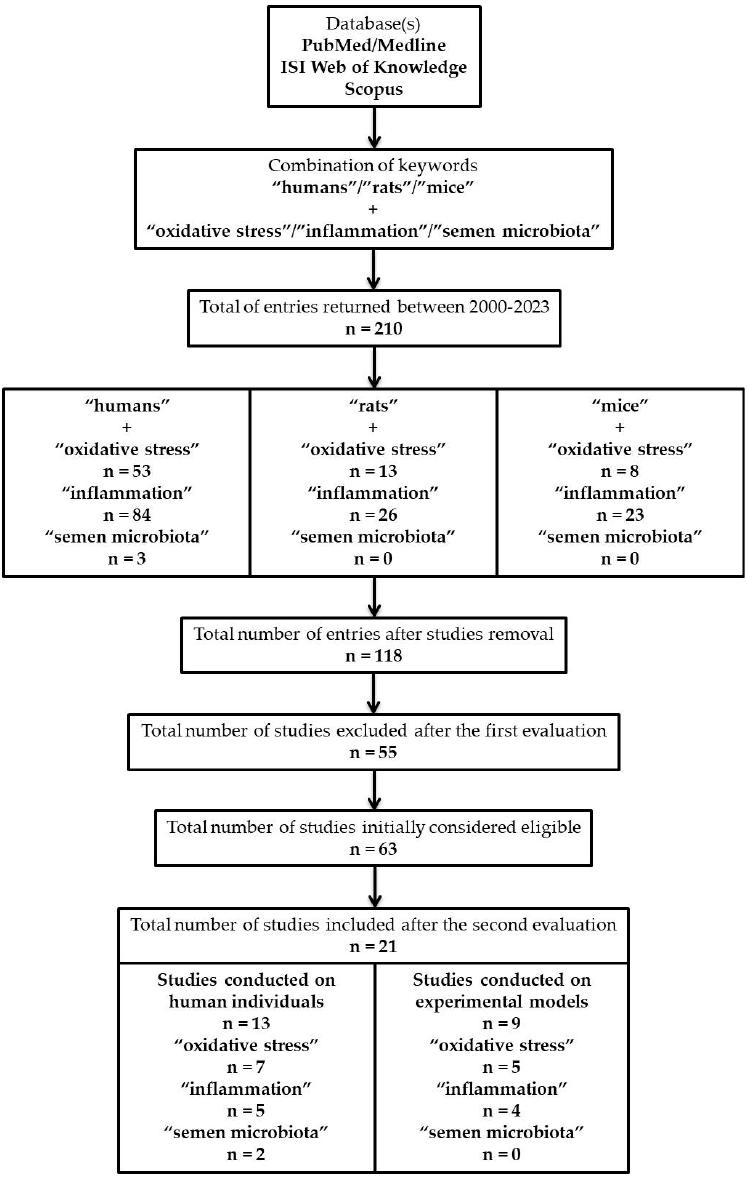
Figure 2. Flowchart diagram presenting the study design with the academic databases(s)